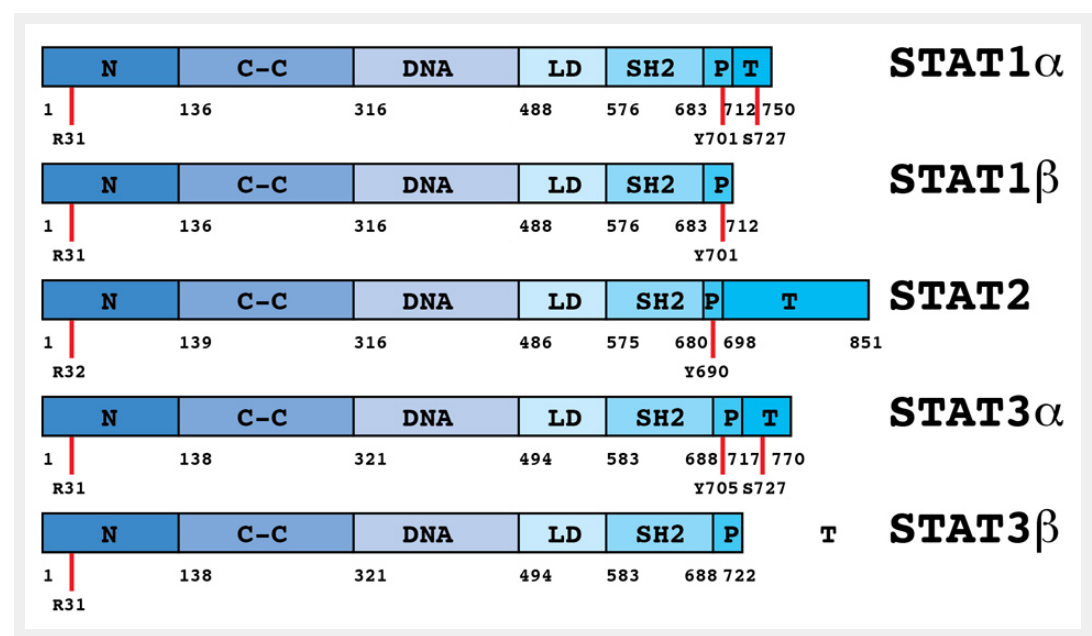
Figure 4 Domain structure of STATs. There are seven STAT genes in the human genome, coding for STAT1, STAT2, STAT3, STAT4, STAT5a, STAT5b and STAT6. Differential splicing and posttranslational cleavage can form multiple isoforms. For IFN signaling, STAT1 and STAT2 (and in some cells STAT3) are most important. STATs are between 750 and 850 amino acids long. All STATs share well-defined, structurally and functionally conserved domains including the amino-terminal (NH2), coiled-coil, DNA-binding, linker, SH2, tyrosine activation, and transcriptional activation